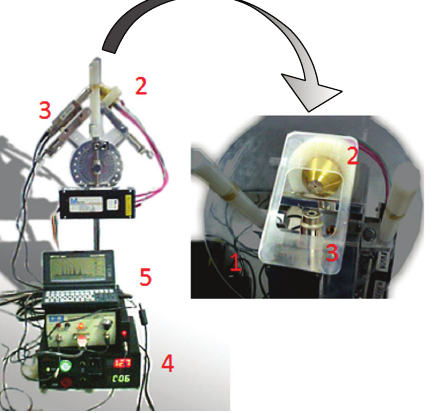
Figure 2: Portable X-Ray Fluorescence system: (1) sample support, (2) X-ray minitube, (3) X-ray detector, (4) standard electronic (5) laptop computer.